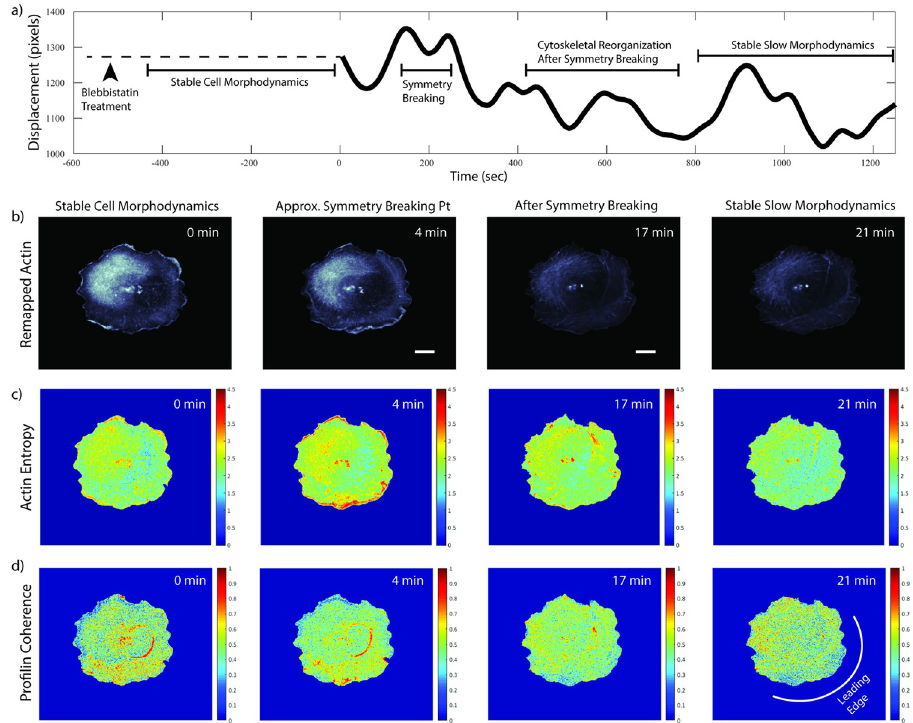
Fig 7. Cell symmetry breaking reveals polarization dependent organization of Profilin coherence a) Time course of a drug-induced symmetry breaking experiment, following the protocols published in [39]. 500 s prior to imaging cells seeded on glass slides are treated with 25 μ M Blebbistatin. During the initial phase after drug induction the cells exhibit a stable morphology (not filmed). The remainder of the displacement time course (total cell edge displacement integrated over the cell boundary) displays distinct phases of cell morphodynamic activity, as indicated. Symmetry breaking occurs 150–250 s into the movie. b) Remapped mNG-Actin signals at four select time points. See Fig 1b for the original image sequence. The cell registration relied on Halo-CAAX as a location fiducial. c) Actin entropy computed over a rolling window of 25 time points. d) Profilin time-series coherence score computed over a rolling window of 25 time points. Both the Actin entropy and Profilin coherence reveal a shift in high values away from the cell front to the cell center and back during the symmetry breaking process showing that Profilin organization is responsive to changes in subcellular Actin polymerization. See text for further discussion. All scale bars 10 μ